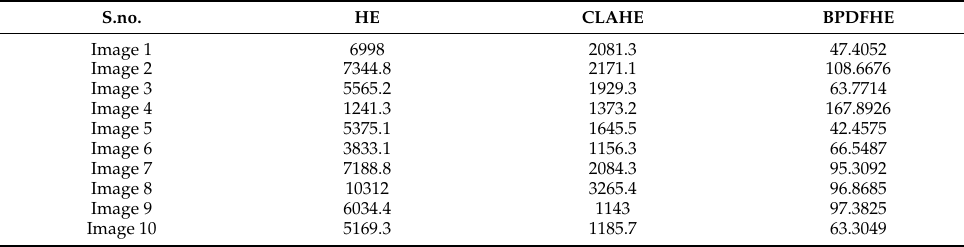
Table 1. Comparison of MSE values.